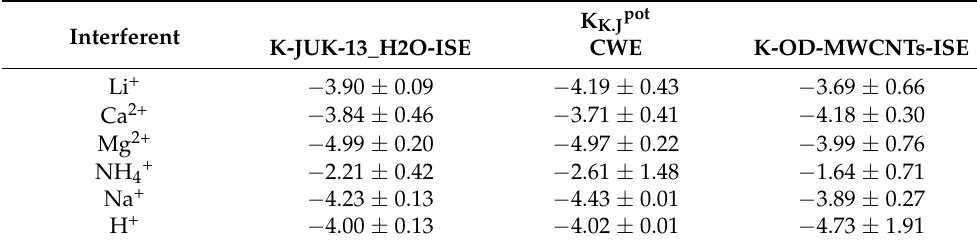
Table 2. Comparison of the potentiometric selectivity coefficients for proposed K-JUK-13_H2O-ISE, coated wire electrode (CWE) and K-OD-MWCNTs-ISE (with the same ion-selective membrane) ( n = 3, α = 0.05).